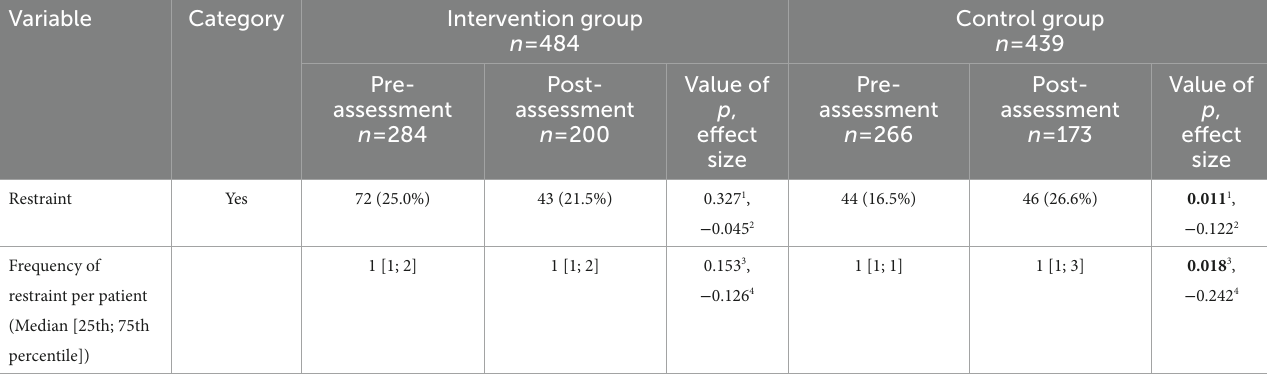
TABLE 2 Restraint-related data per group (IG or CG) regarding all patients treated before (pre) and after (post) the implementation of peer support ( n = 923). Variable